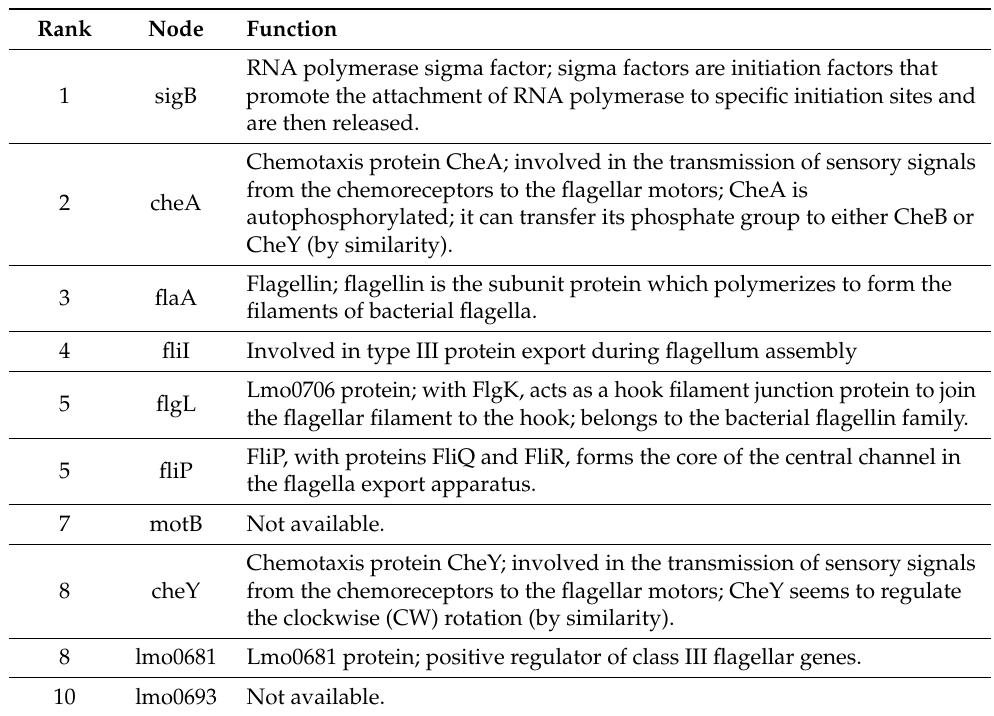
Table A3. Summary of top 10 nodes for virulence.